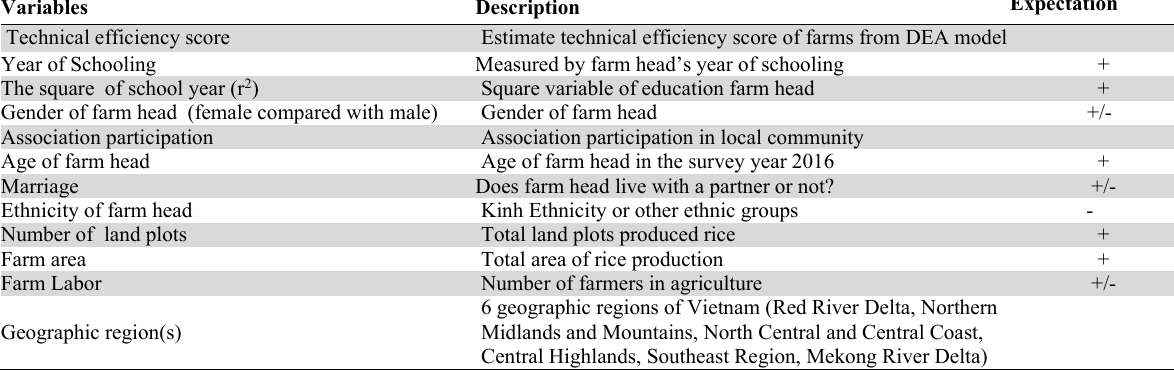
Description and pretension sign in the technical efficiency